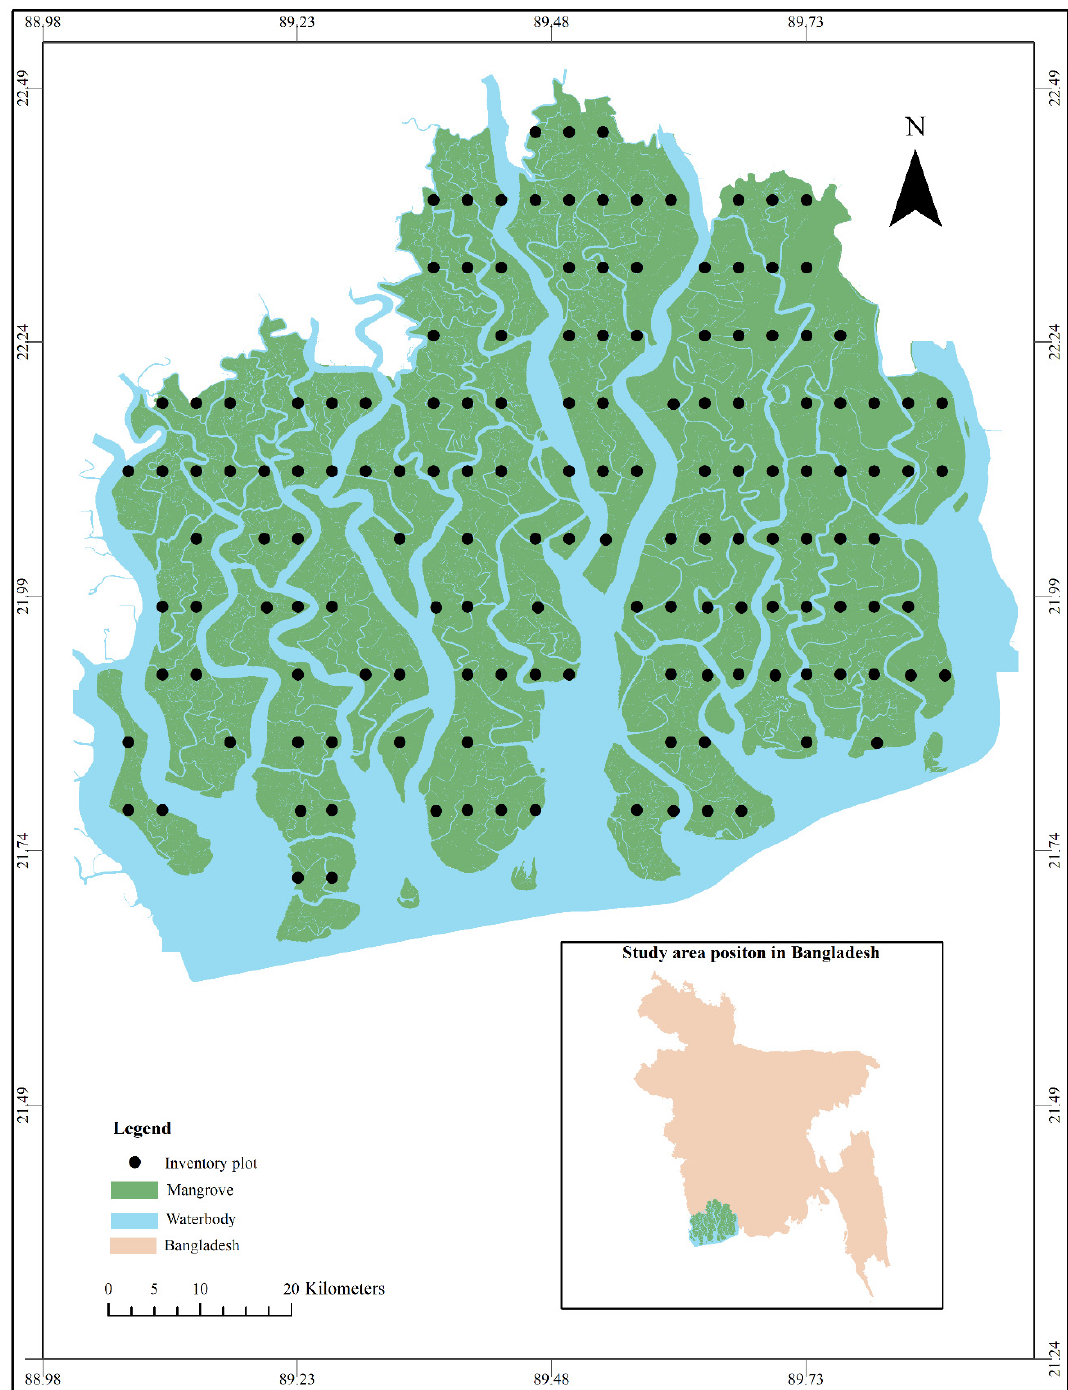
Figure 1. Distribution of sampling plots in Sundarbans Reserved Forest .